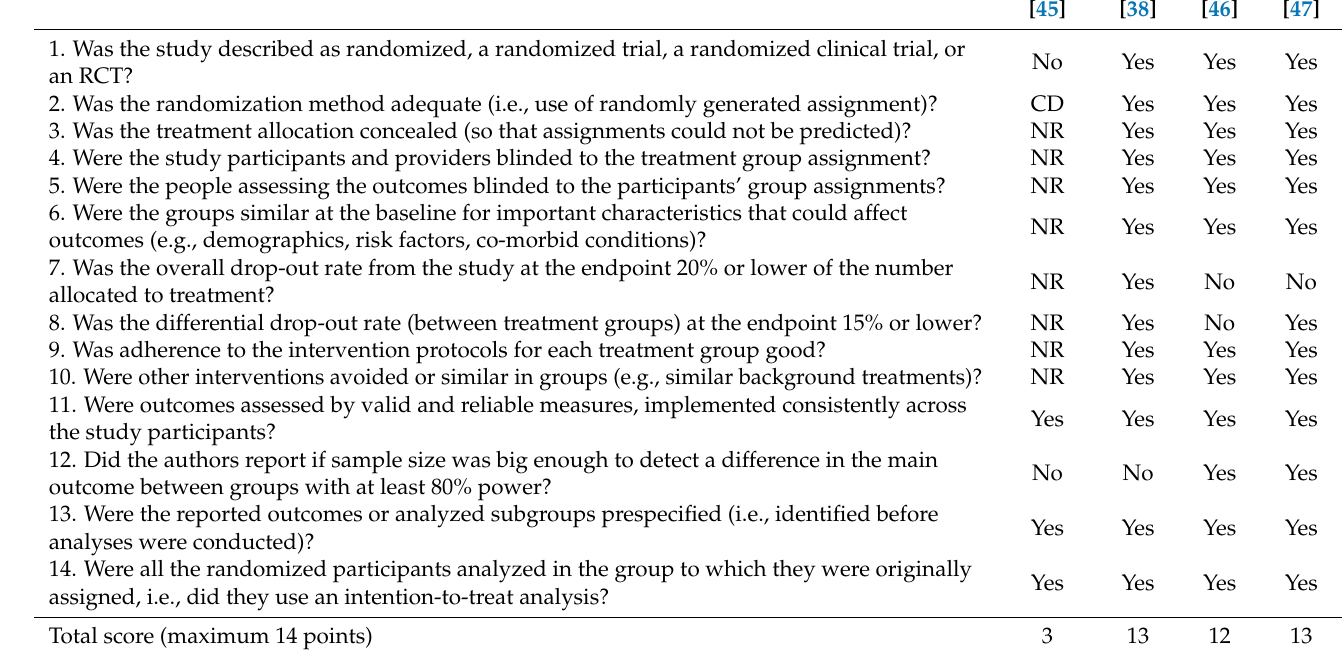
Table A3. Quality assessment of Controlled Intervention Studies